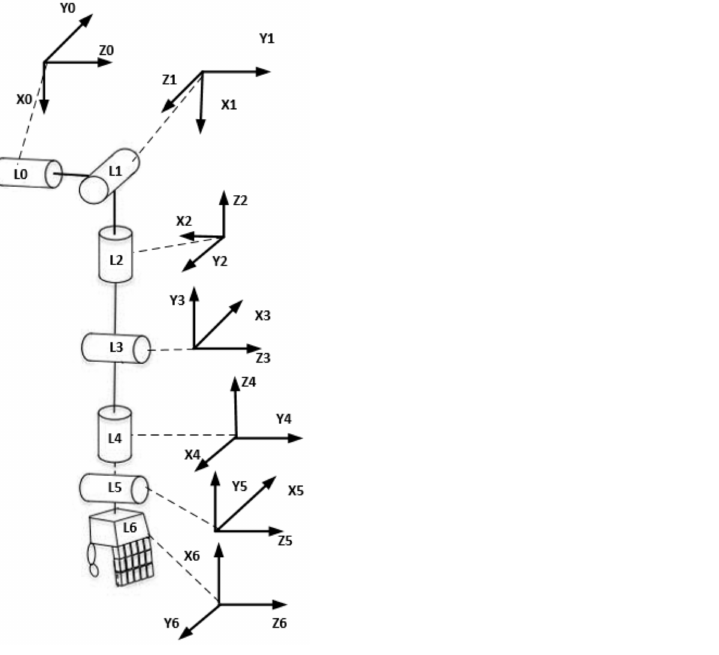
Figure 5. The kinematic diagram of the robot SAR-401 left manipulator. The Denavit–Hartenberg parameters for the left manipulator of the robot SAR-401 are shown in Table 1. Table 1. DH parameters for the left manipulator of the robot